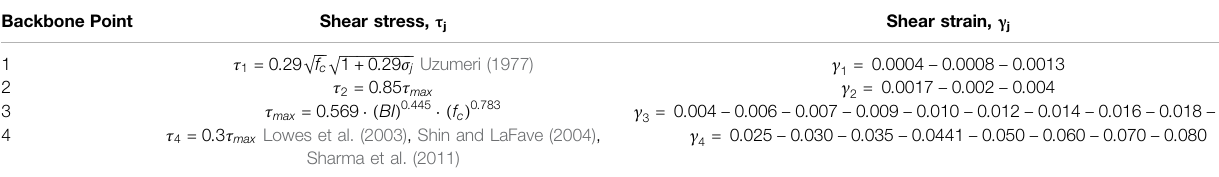
TABLE 5 | Selected shear stress values and proposed ranges for γ i parameters. Backbone Point Shear stress, τ j Shear strain, γ